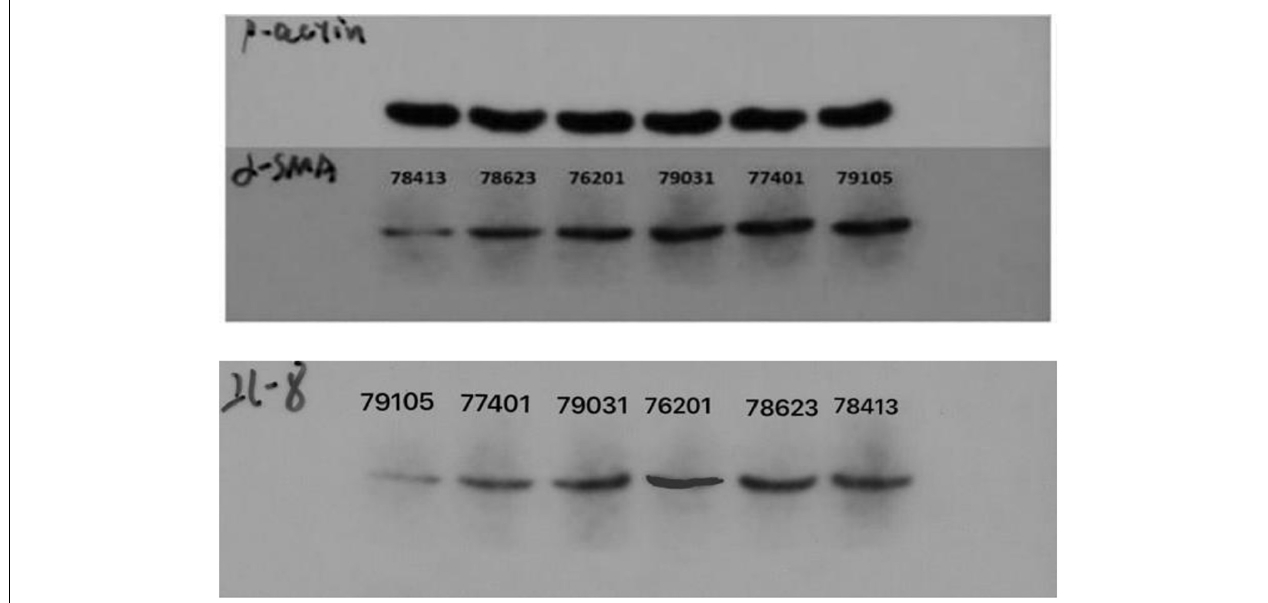
FIGURE 14 | The electrophoretogram of ACTA2 ( α -SMA) and CXCL8 (IL-8) at CT-LCG and FT-LCG.